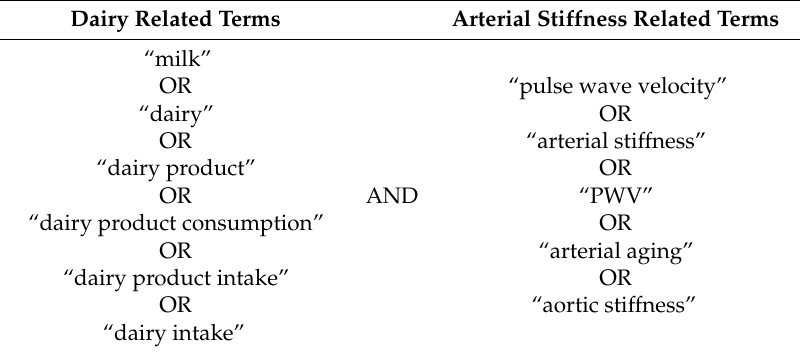
Figure 1. Literature search PRISMA (Preferred Reporting Items for Systematic Reviews and Meta-analyses) consort diagram. Table 1. Search strategy for Medline.